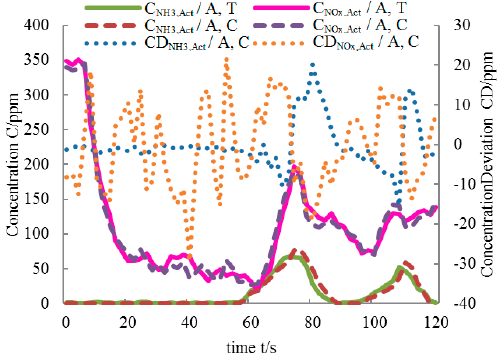
Figure 10. The values and deviations of the NO x and NH 3 after the correction.